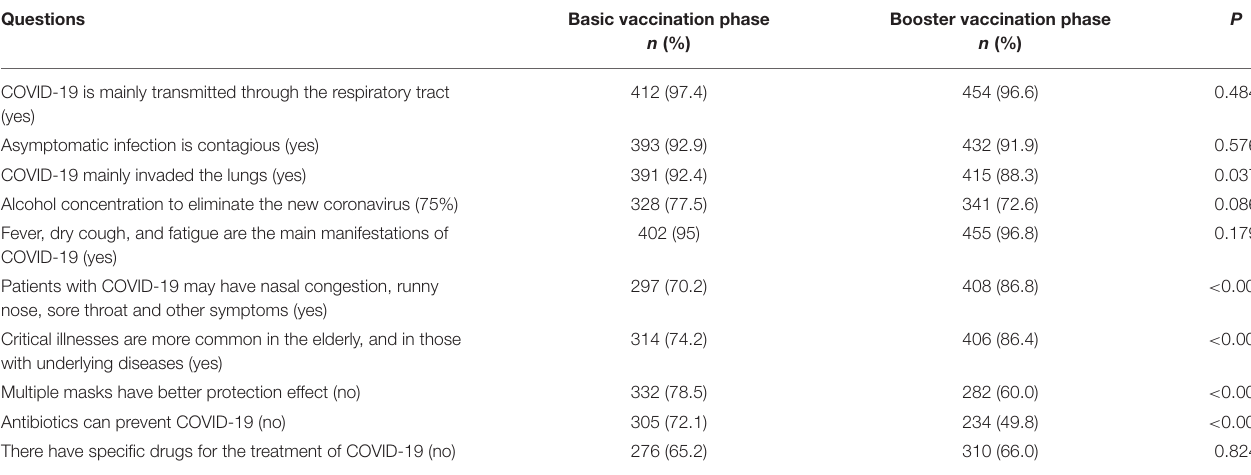
TABLE 2 | Comparison of correct knowledge about COVID-19 between two